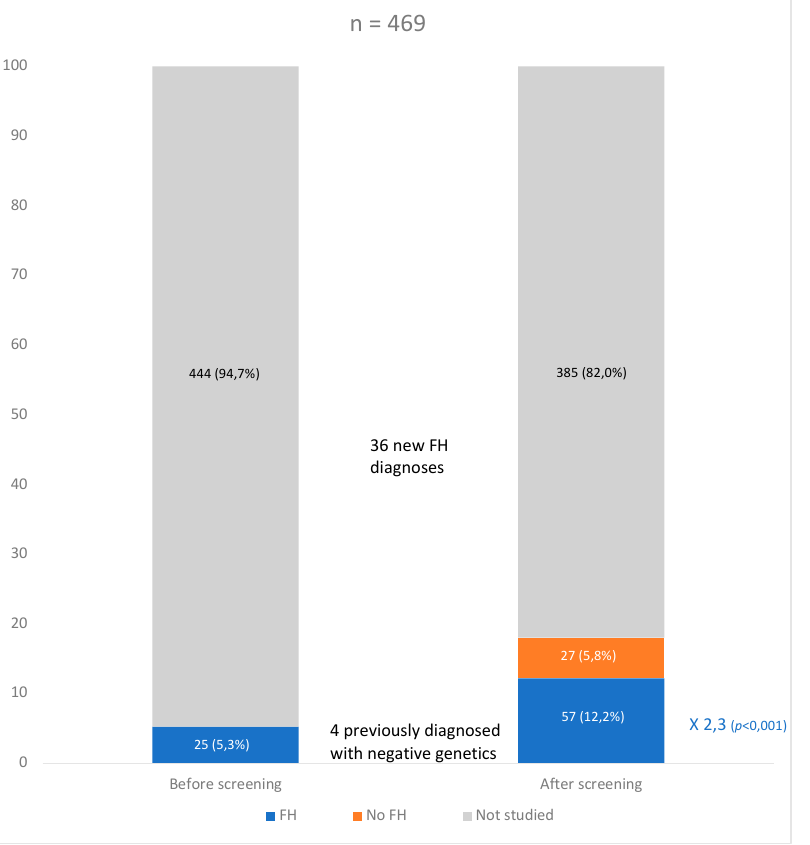
Figure 3. Diagnostic percentage of familial hypercholesterolemia, before and after screening, Bar graph where we can appreciate the percentage of diagnosis of familial hypercholesterolemia (FH) in the DLCN ≥ 6 group before carrying out the screening strategy (25 patients, 5.3%; although 4, 0.9%, had negative genetics and 21, 4.4%, were positive) and after the strategy (57, 12.2%, genetically confirmed with 2.3-fold increase in FH diagnosis, p < 0.001). The 10 patients with DLCN 3–5 and genetic study were counted as not studied. DLCN: Dutch Lipid Clinic Network.